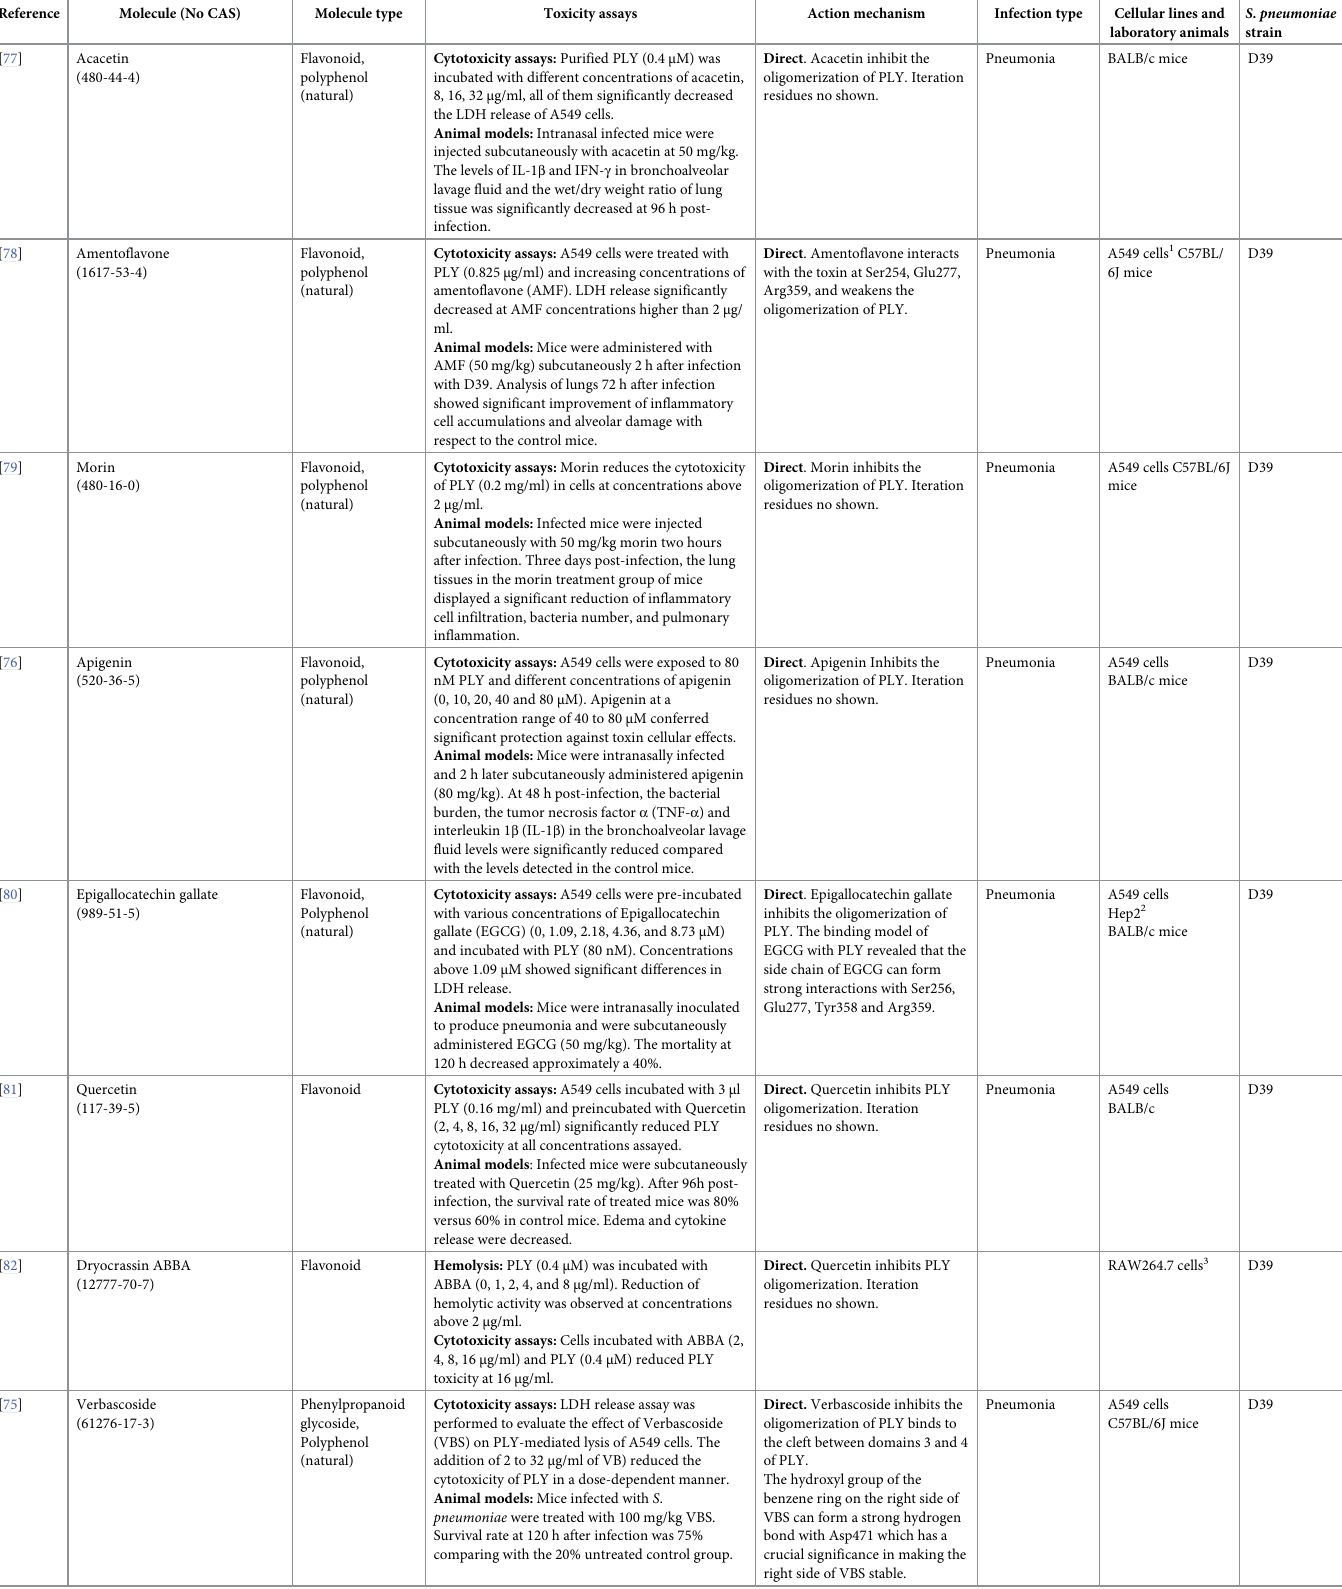
Table 1. Basic characteristics of the articles included into this report show the molecules with effects against PLY. Reference